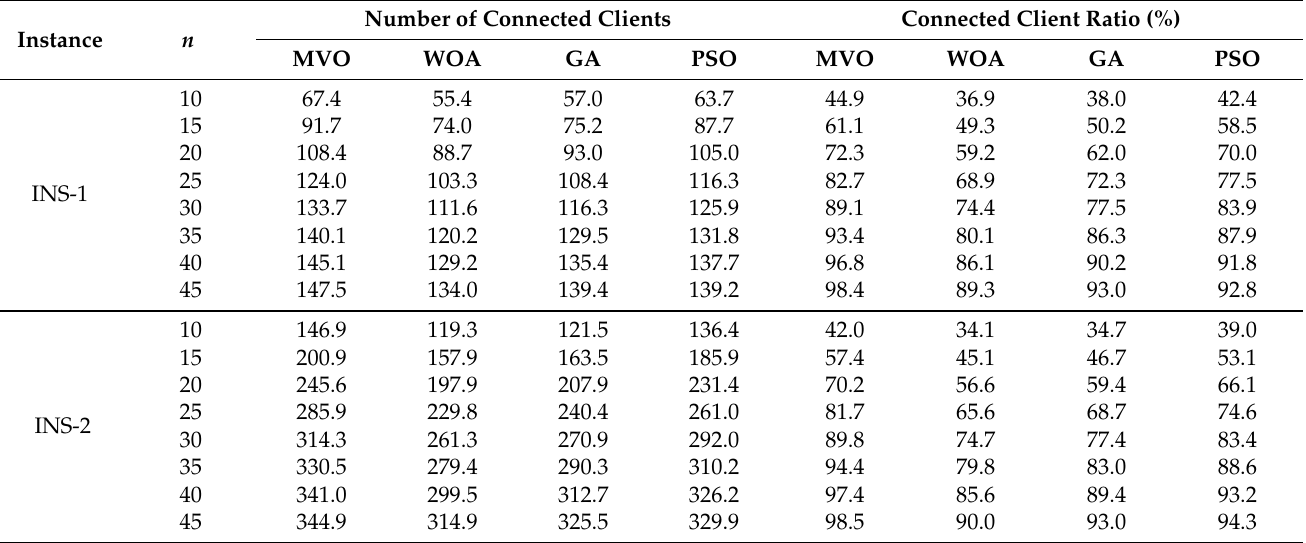
Figure 5. Performance comparison of the CCR versus the number of routers. ( a ) INS-1. ( b ) INS-2. Table 6. Performance comparison of the number of connected clients and CCR when executing INS-1 and